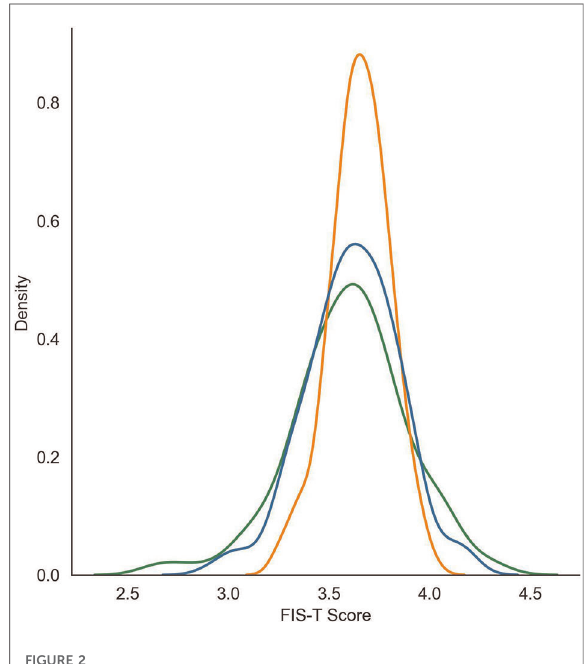
FIGURE 2 FIS-T score distributions for the DistilBERT (BERT) algorithm, support vector regressor (SVR), and ground truth (human)